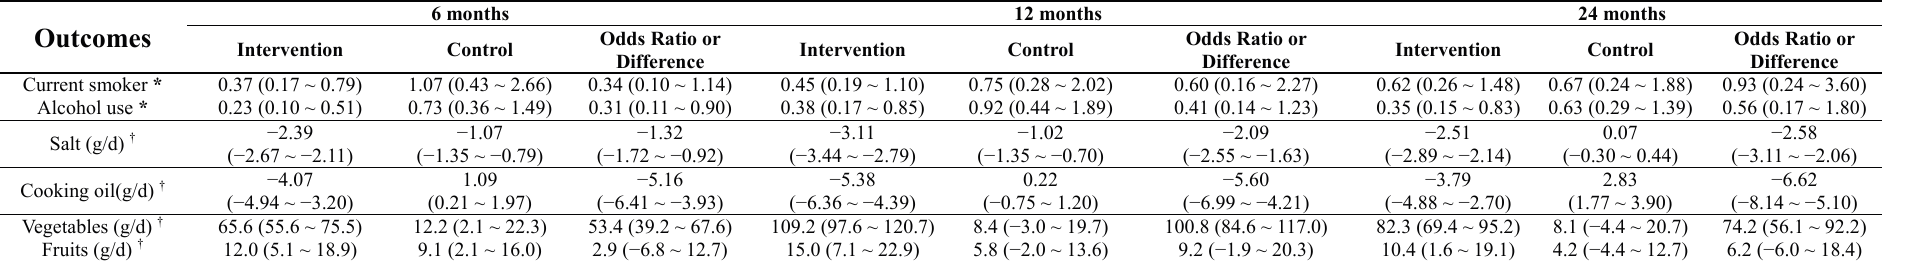
* Estimates are odds ratios from a logistic mixed-effects regression adjusted for sex, age, education and baseline values. Values less than 1 reflect improvement compared with baseline values or the control group, and values higher than 1 reflect deterioration; † Estimates are based on a linear mixed-effects regression adjusted for sex, age, education and baseline